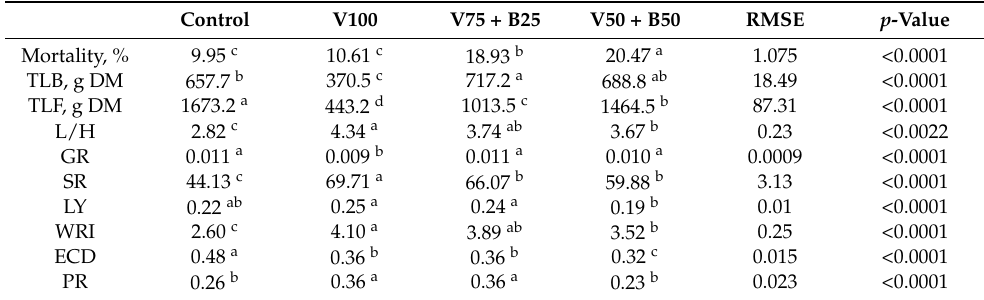
Table 5. Growth performance of black soldier fly larvae calculated at the end of the trial. Control